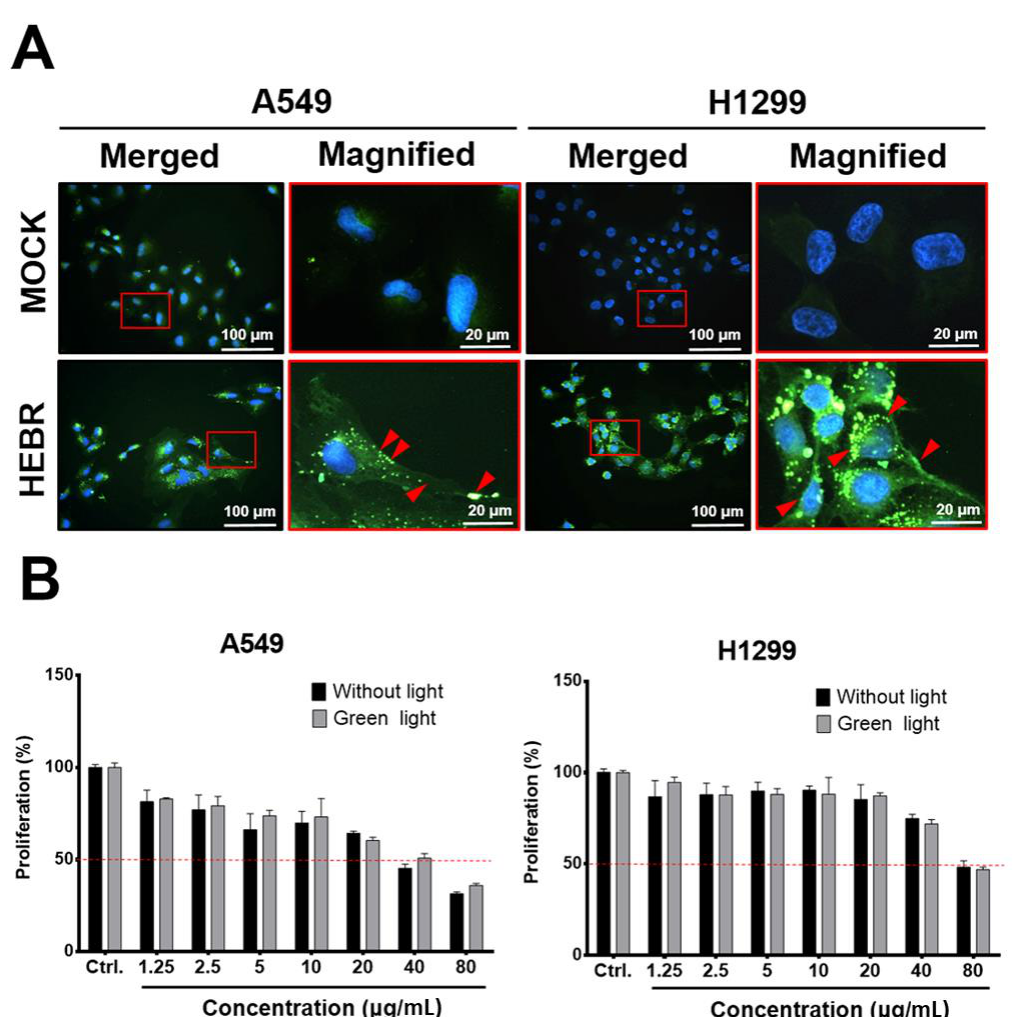
Figure 1. The effect of HEBR on the cell proliferation of A549 and H1299. ( A ) The distribution of HEBR protein expression on cell membranes and in the cytoplasm. Immunofluorescent staining HEBR was incubated with the HEBR proteins (20 µ g/mL) on A549 or H1299 cells for 24 h. Immunofluorescence imaging of HEBR-his tag (green) counterstained with nucleic Hoechst (blue), and then merged. The magnified image of the selected region is shown in the red box. The HEBR proteins on cell membranes are demonstrated by red arrows. ( B ) The cell proliferation rate of A549 and H1299 after treatment with HEBR protein for 48 h evaluated by CCK-8 assay. The data are expressed as the relative proliferation of cells. The black bar represents the treatment of HEBR protein without green-light illumination, while the gray bar represents the treatment of HEBR with green-light illumination. The proliferation percentage at different HEBR concentrations was evaluated by GraphPad Prism 5 software.